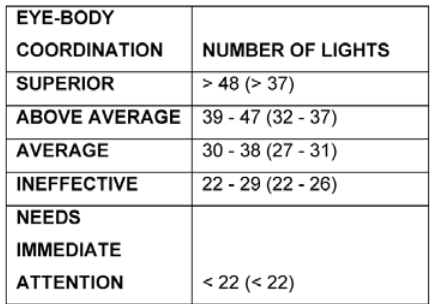
Table 5: The norms for eye-body coordination with the use a balance board connected to the Computerized Wayne Saccad - ic Fixator. The results in brackets are the results obtained by Buys 4 .